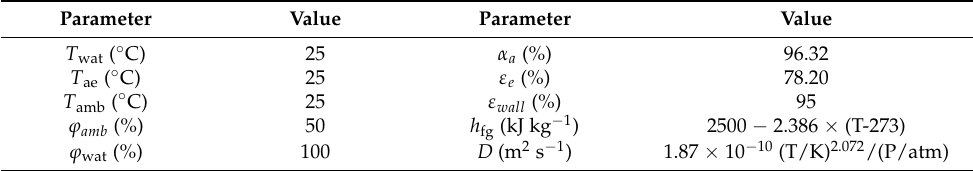
Table 2. Input parameters for the 3D COMSOL Multiphysics models.